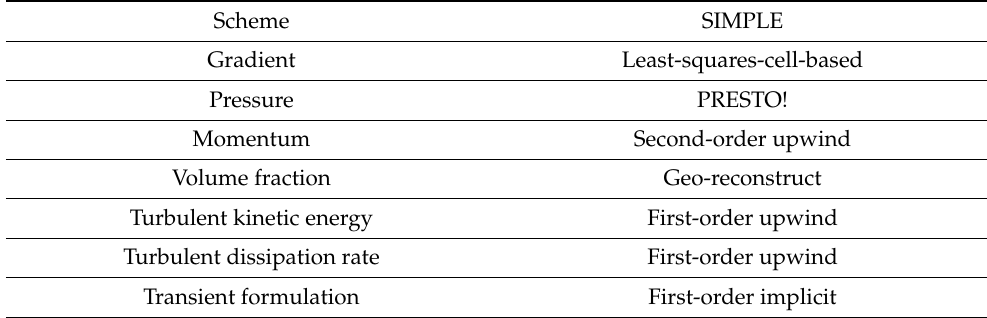
Table 5. Solution methods.